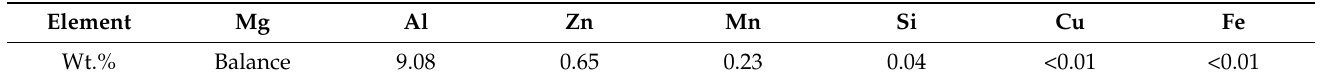
Table 1. Chemical composition of magnesium alloy AZ91D